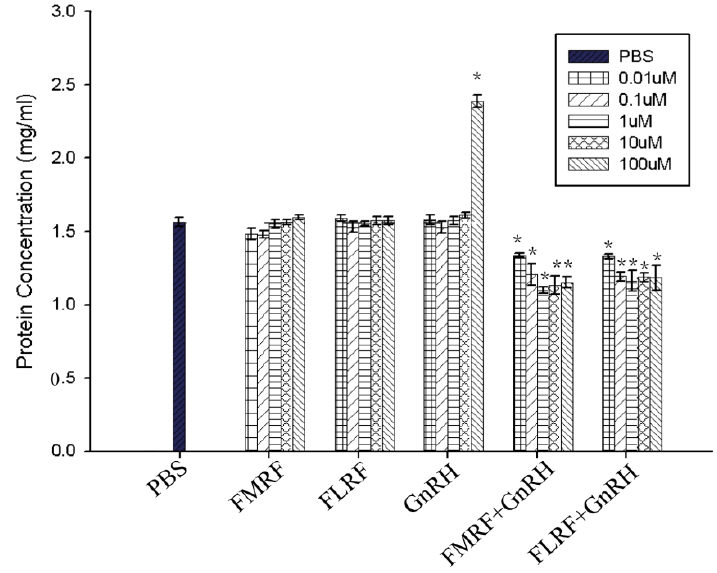
Figure 5. The e ff ect of Sp FMRFamide, Sp FLRFamide, or Sp GnRH and the associated e ff ect of Sp FMRFamide + Sp GnRH or Sp FLRFamide + Sp GnRH on protein secretion in CHO-K1. Statistical significance of results was analyzed by one-way ANOVA followed by Tukey’s post-tests. Significant di ff erences ( p < 0.05) are noted by ‘*’ over each concentration group compared to the control (phosphate bu ff er saline treated, PBS group).